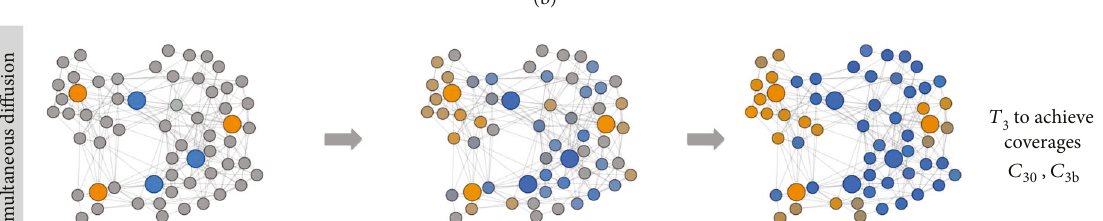
or T , nor will they achieve such high coverages as C 1 2